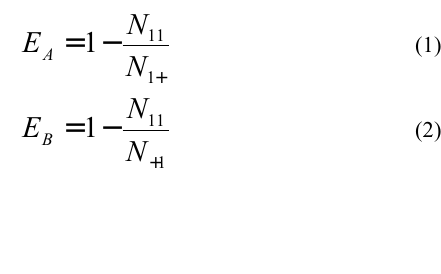
Figure 2: Matrix of correspondence between change (1) in map A and